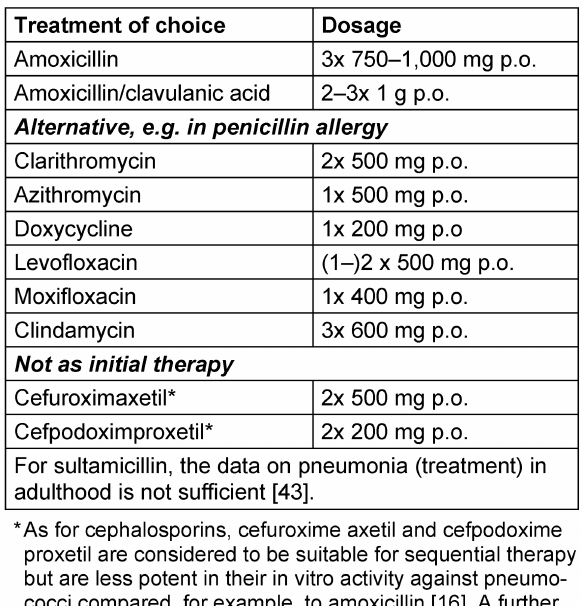
Table 5: Oral sequential therapy in patients with CAP after achieving clinical stability and without pathogen